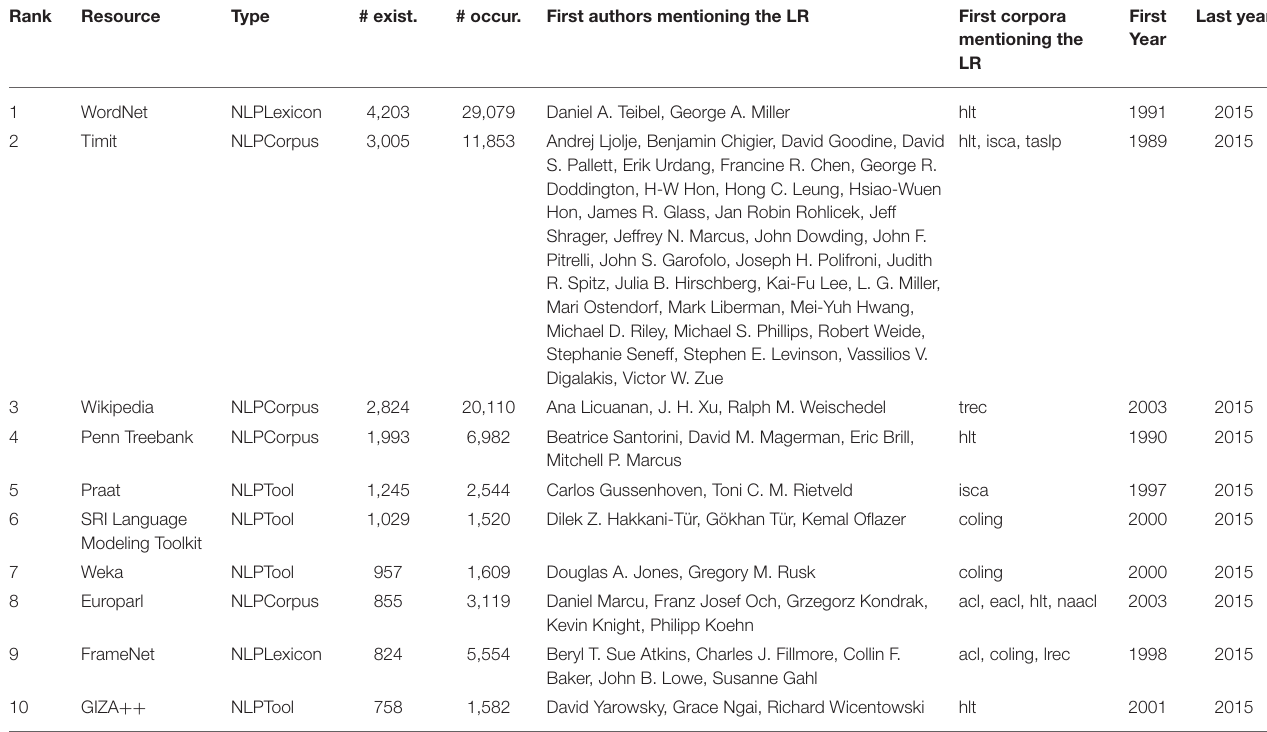
TABLE 7 | Presence of the LRE Map Language Resources in the NLP4NLP articles. Rank